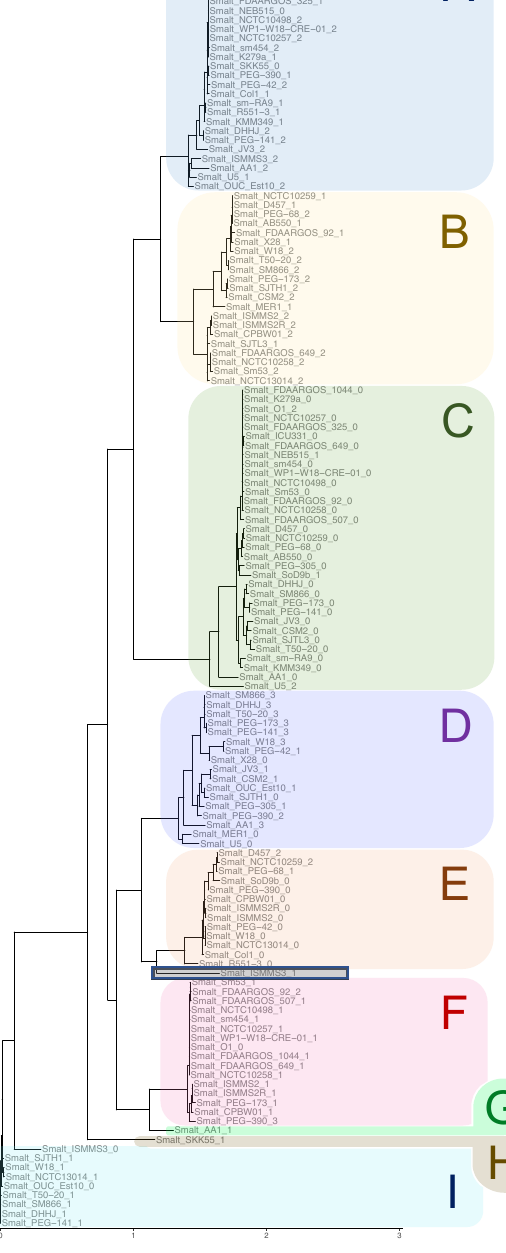
Figure 5 - Phylogeny of RAYT genes and their associated REPINs. The tree shows RAYT genes from 49 S. maltophilia strains. Colours of clades A-I are assigned according to their association with a REPIN found within 200 bp